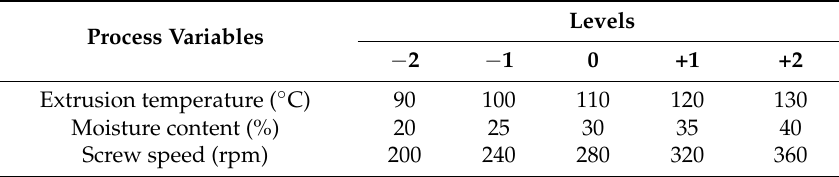
Table 7. Process variables and levels used in the experimental